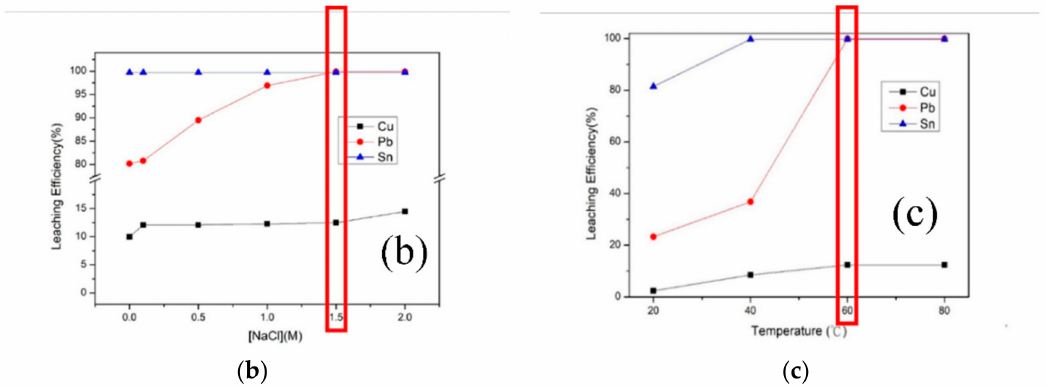
Figure 8. The optimized parameters of removing PV ribbon’s coating layer: ( a ) Optimizing reaction times, ( b ) concentration of NaCl (M), and ( c ) reaction temperature.